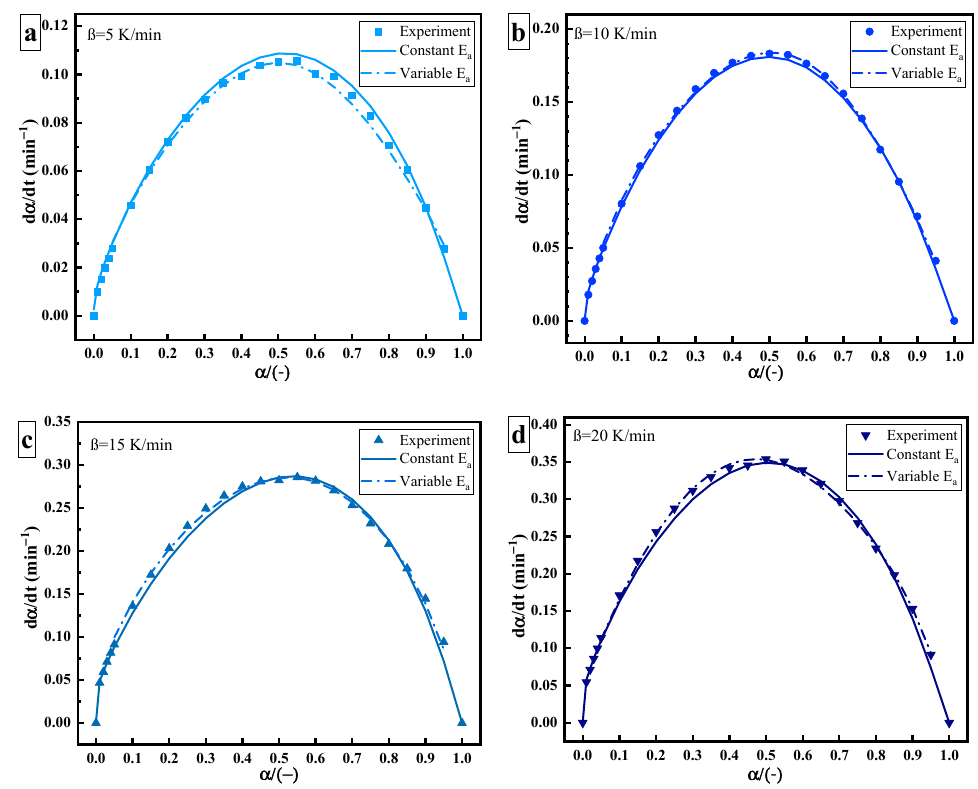
Figure 6. Curing rate–curing degree curves of thermal curing: heating rate of ( a ) 5 K/min;